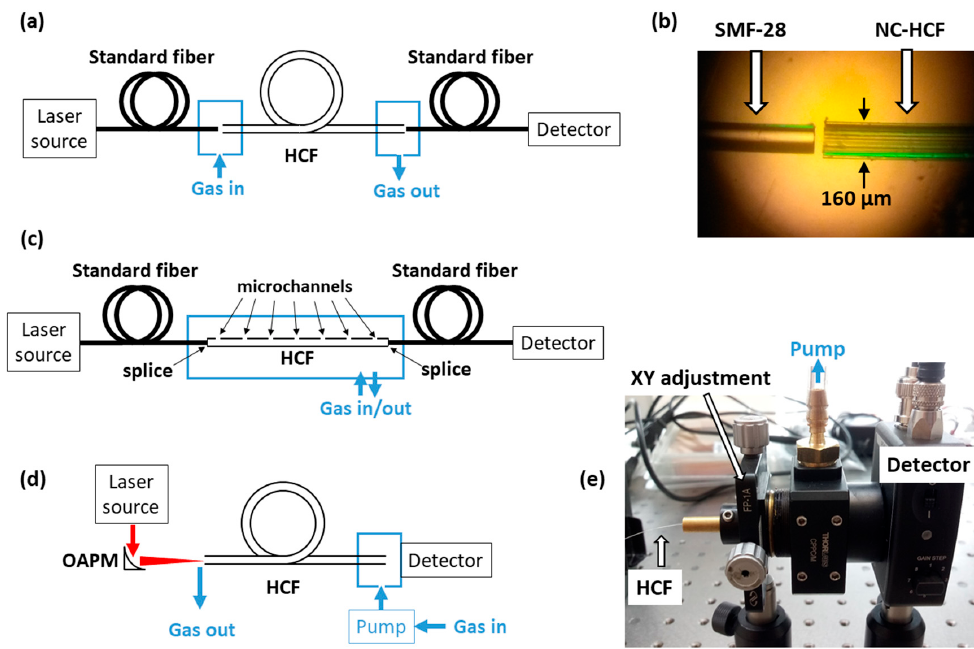
Figure 2. Potential configurations of hollow-core fiber (HCF)-based gas sensing systems: ( a ) HCF is butt-coupled with a standard single-mode fiber; ( b ) picture of a standard SMF-28 fiber coupled with negative curvature (NC) HCF; ( c ) HCF is spliced to a solid-core fiber from both sides, and gas enters/exits the fiber through microchannel drills along the HCF; ( d ) light is coupled into HCF using bulk optics, mirrors, or lenses (OAPM—off-axis parabolic mirror); ( e ) picture of air-tight housing which allows the HCF to be aligned with the photodetector and filled with a gas sample.